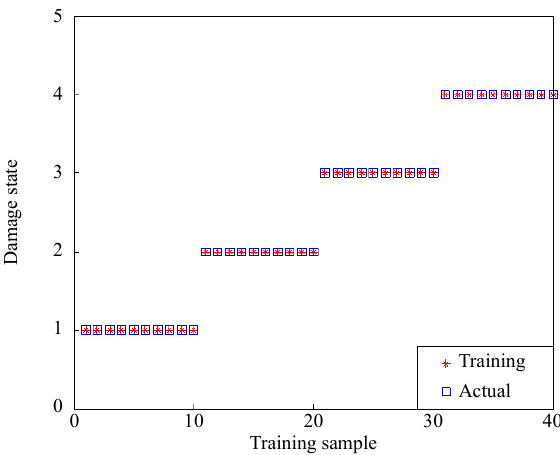
Fig. 9 Training results of the BP neural